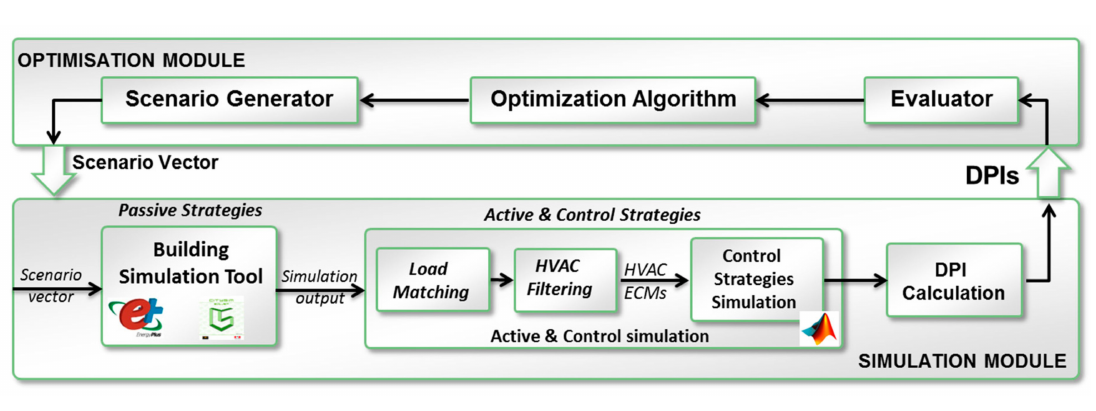
Figure 2. Decision-support platform based on simulation and optimization modules. DPI—district performance indicator; HVAC—heating, ventilation, air